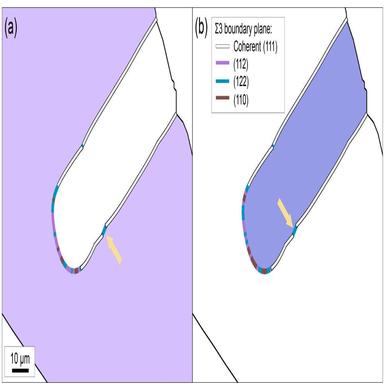
GB planes with the smallest trace deviation for incoherent Σ3 segments for (a) grain 1 (coloured light purple) and (b) grain 2 (coloured dark purple).